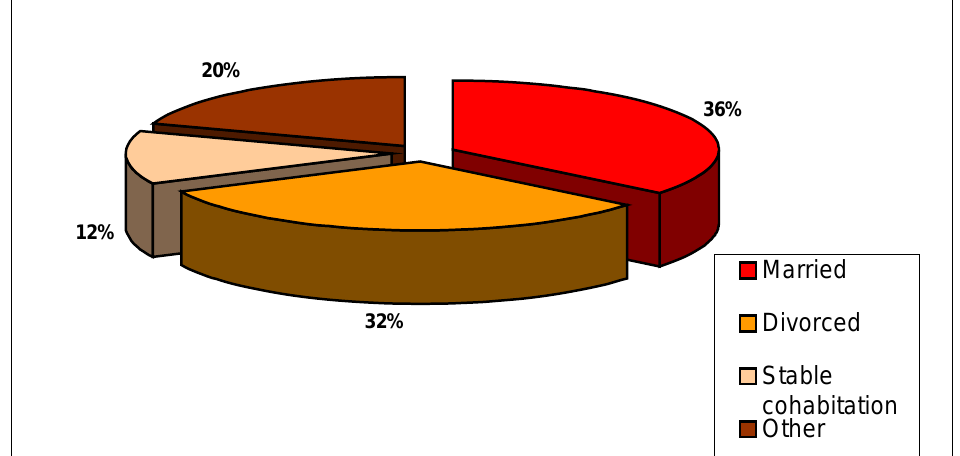
FIGURE 1. Characterization of civil status of the parents of pregnant